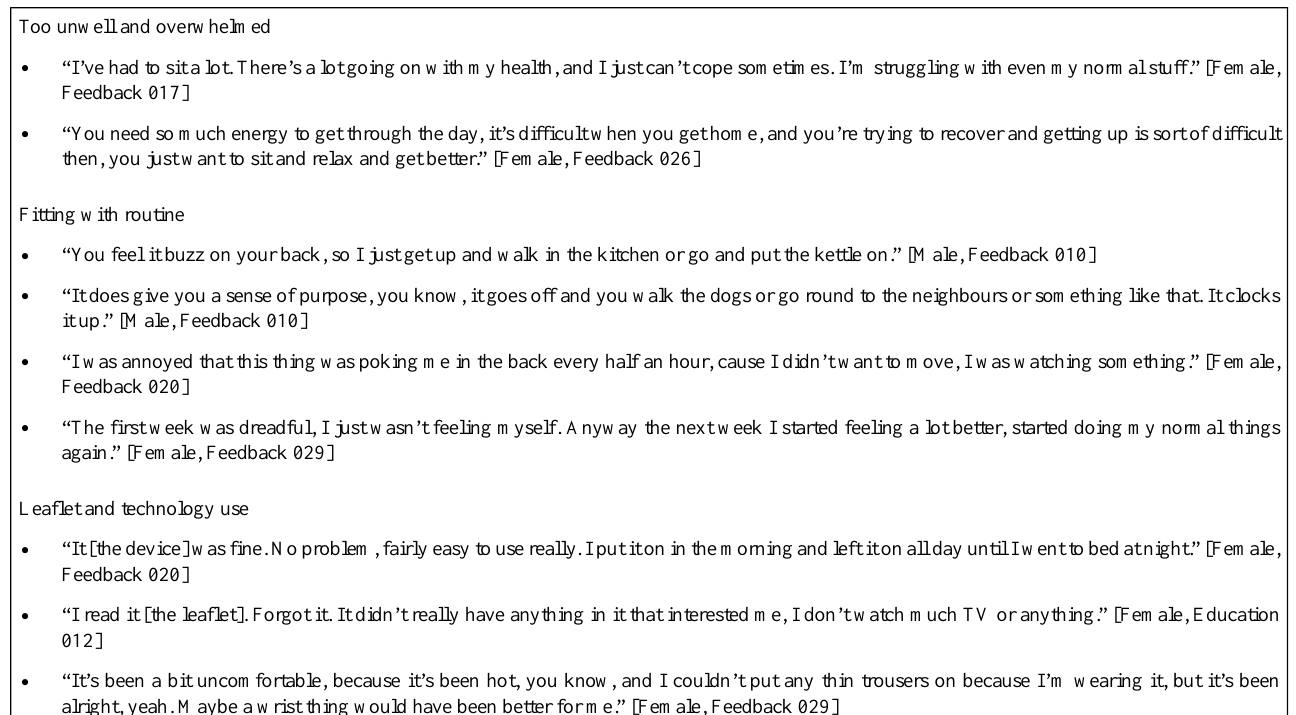
Textbox 3. Patient panel: illustrative quotes from patient qualitative interviews.